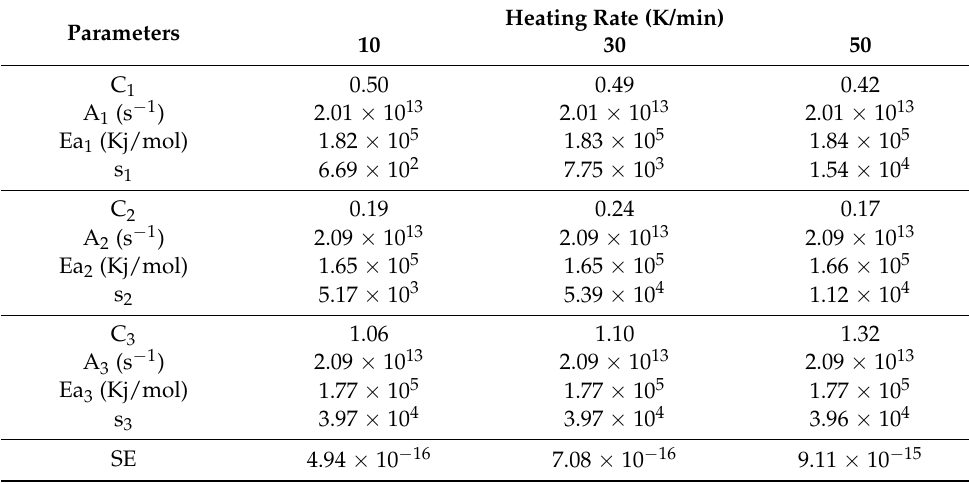
Table 9. Kinetics results DAEM model for the EFB + 2% Zn